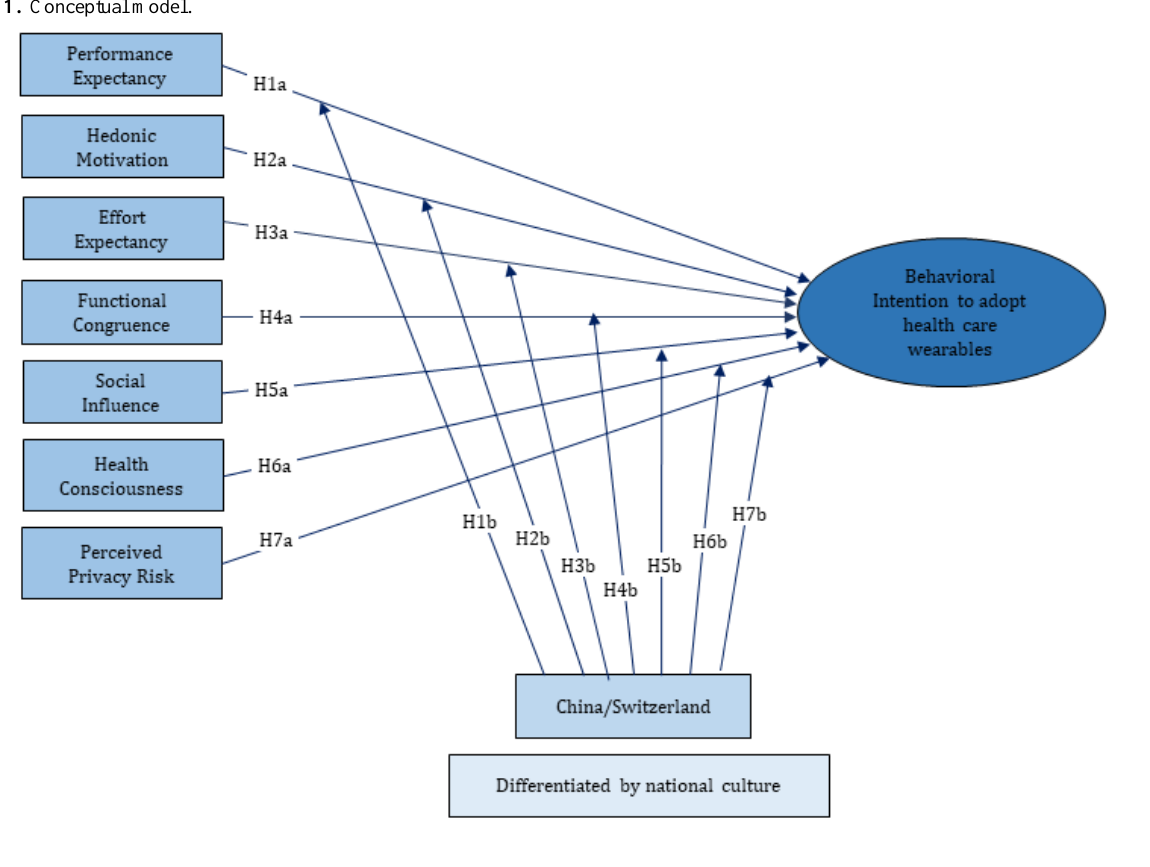
Figure 1. Conceptual model.